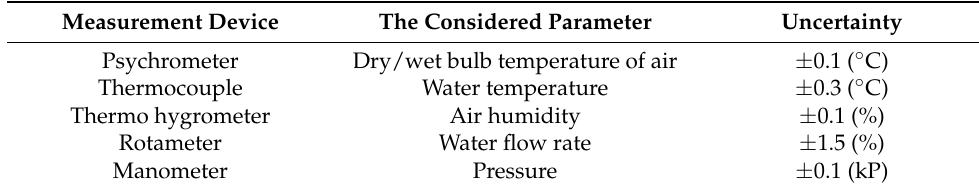
Figure 2. Schematic packing dimension. Table 1. The instruments for measuring the experimental data.